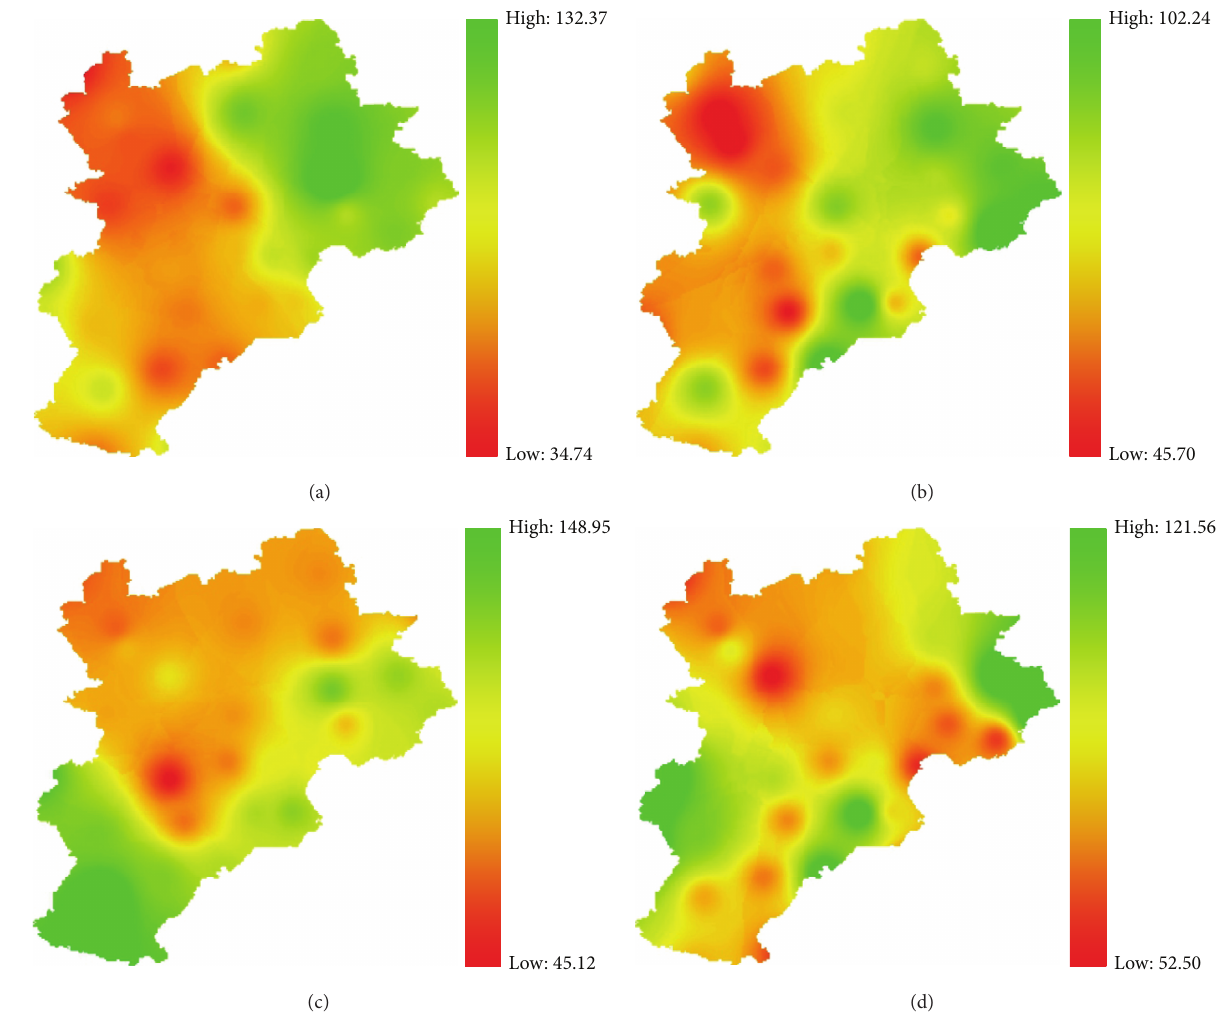
Figure 3: Spatial distribution of percentage of annual mean precipitation relative to 1961–1990 climate normal over the course of the years (a) 1965; (b) 1997; (c) 2000; and (d)